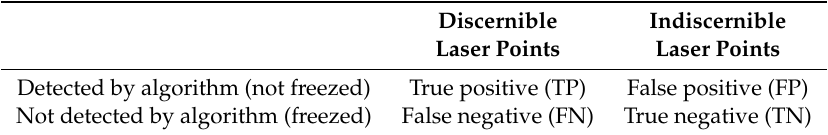
Table 2. Confusion matrix for evaluation of the automated laser point tracking